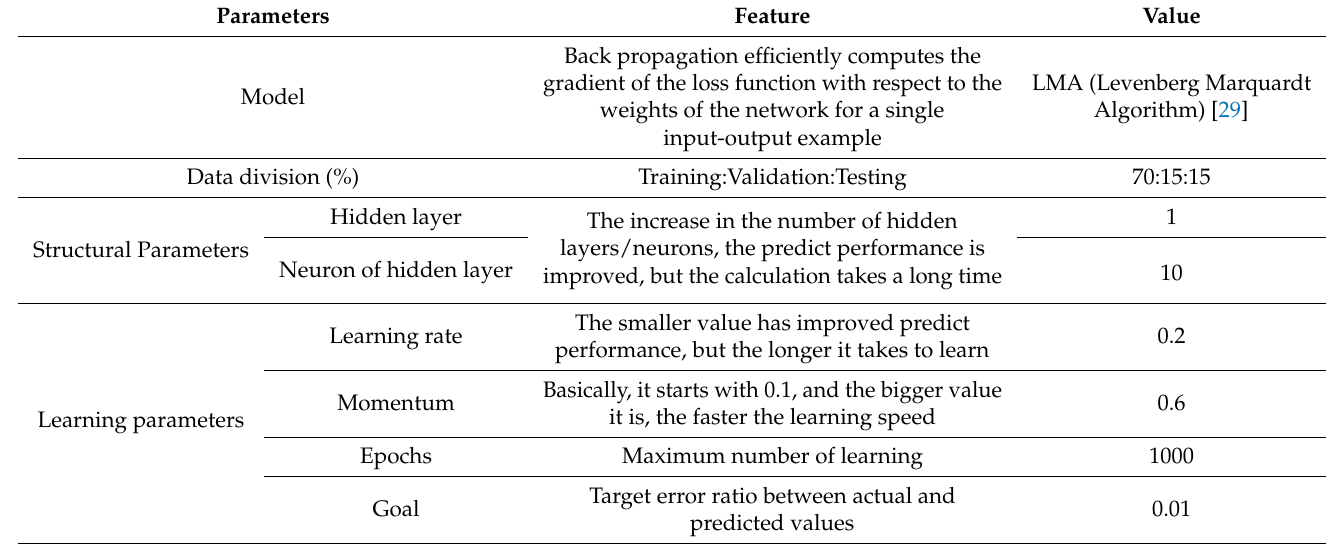
Table 3. Feature and setting value of the structural and learning parameters of initial DNN model.